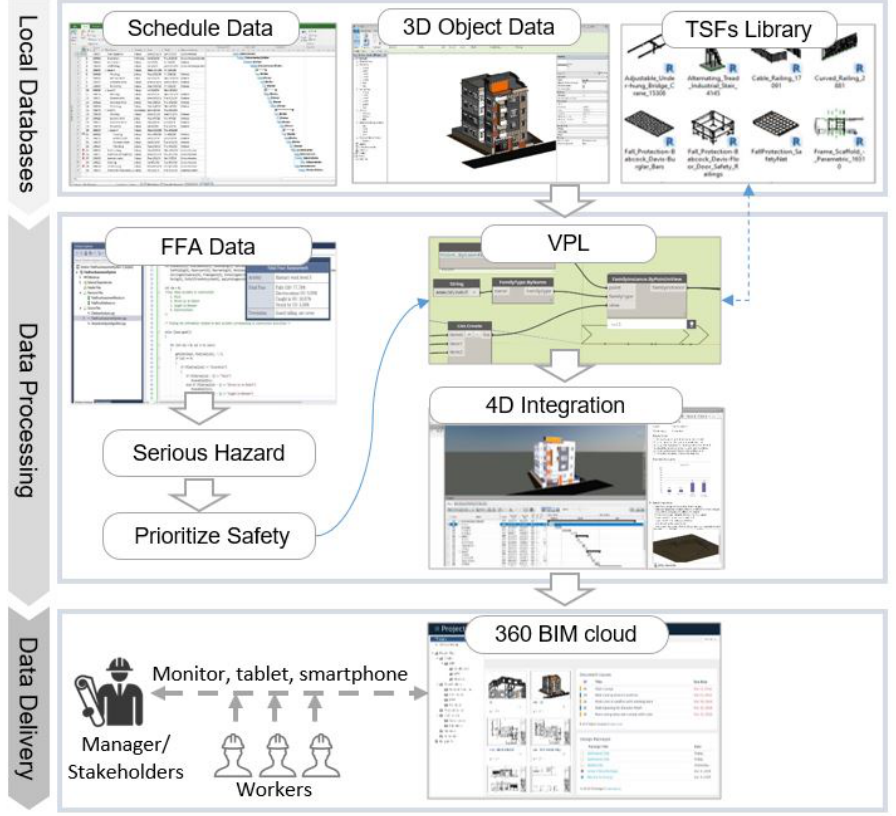
Figure 5. System